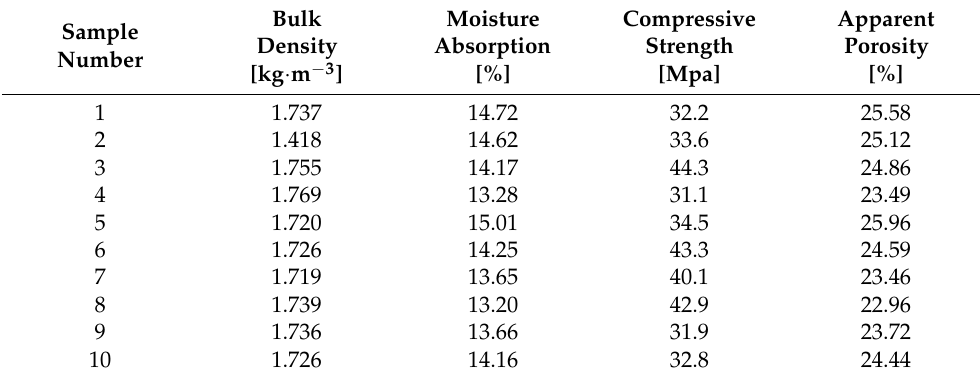
Table 1. Summary of the input parameters of the solid burnt brick samples